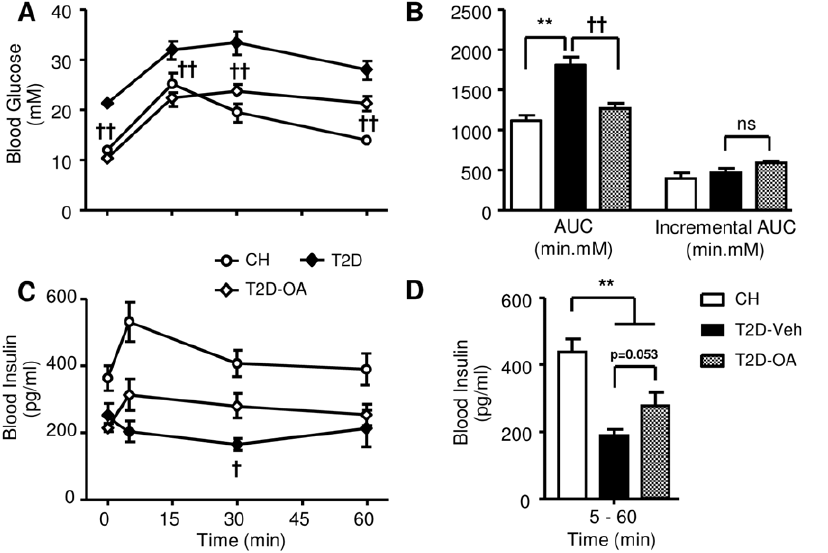
Figure 2. Effects of OA on glucose tolerance and blood insulin. Studies were performed in mice two weeks after the removal of OA. ipGTT was performed with an injection of glucose (1 g/kg, ip ) after 5–7 hours of fasting. Blood glucose was monitored at 0, 15, 30, and 60 min following the glucose injection ( A ). ipGTT results were quantified by calculating the area under the blood glucose curve (AUC) and the incremental AUC (iAUC) ( B ). Insulin levels throughout the ipGTT ( C ). The average value of blood insulin levels from 5 to 60 mins during the ipGTT ( D ). CH, normal chow fed mice; T2D-Veh, HF-fed mice with STZ injections; T2D-OA, HF-fed mice with STZ injections and OA treatment. ** p , 0.01 vs. CH; {{ p , 0.01 vs. T2D-Veh, n=5–8 per group.